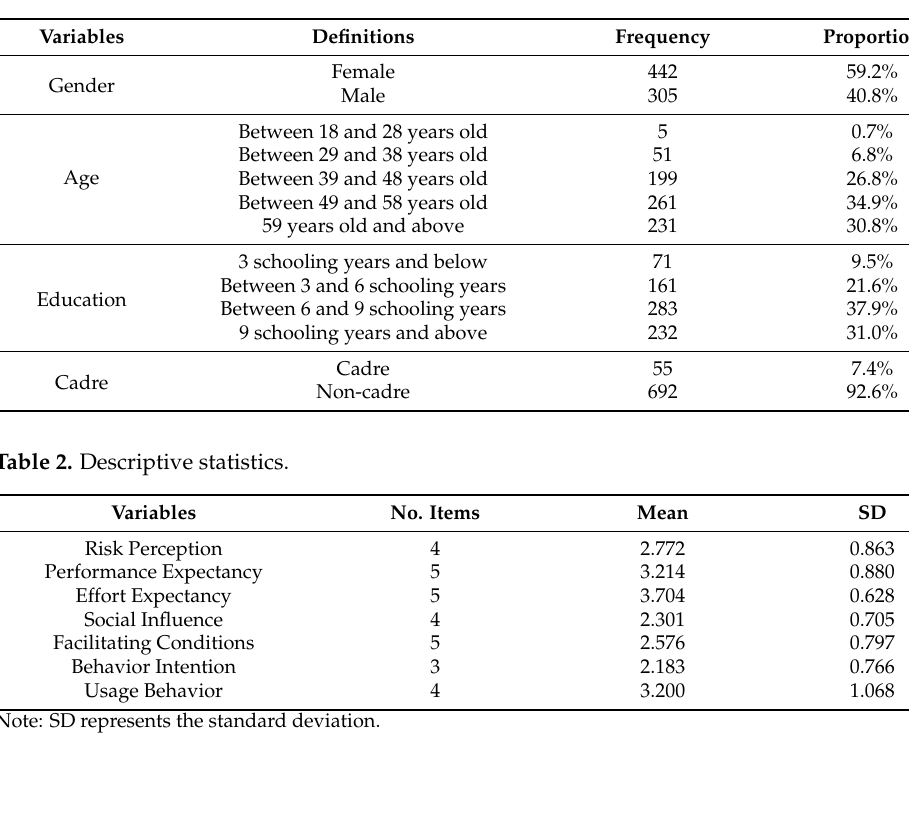
Table 1. Sample characteristics.